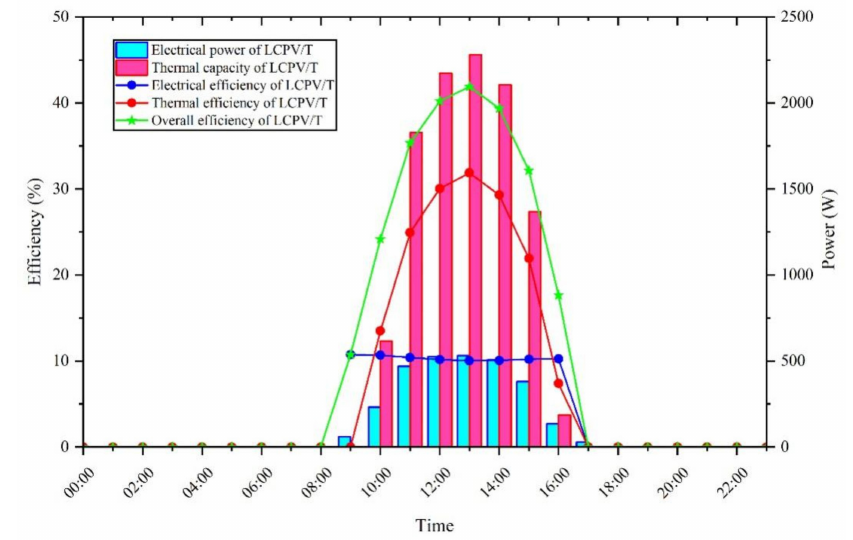
Figure 5. Power and thermal performance of LCPV/T on 15